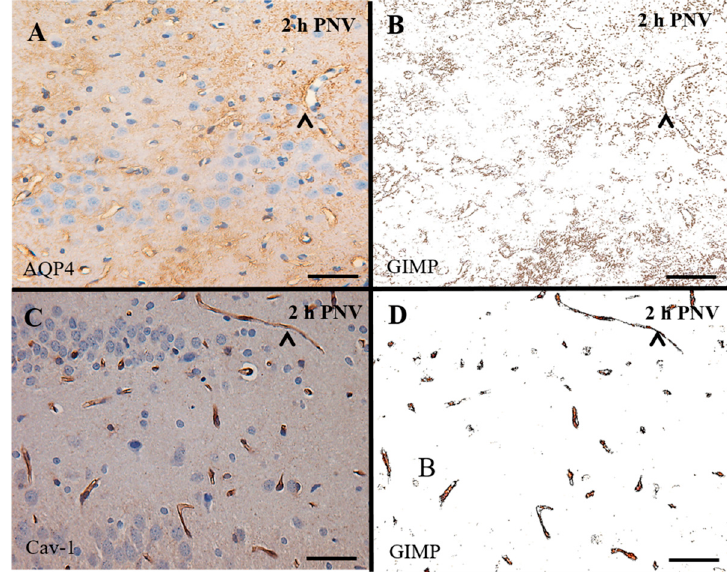
Figure 4. Illustrative image analysis using 2.6.4 GIMP software: ( A , B ) CA3 region of neonate rat 2 h post-PNV labeled with aquaporin-4 (AQP4) and caveolin-1 (Cav-1) antibody (brown) and counterstained with Harris Hematoxylin; and ( C , D ) segmentation by color of the primary antibody reactivity analyzed by 2.6.4 GIMP software for further quantification of density of pixels. ( A , B ) The widespread labeling refers to labeling of astrocytic distal processes; arrowhead shows endothelial labeling; and ( C , D ) labeling of Cav-1 in capillaries endothelium. Scale bars: 50 µm.